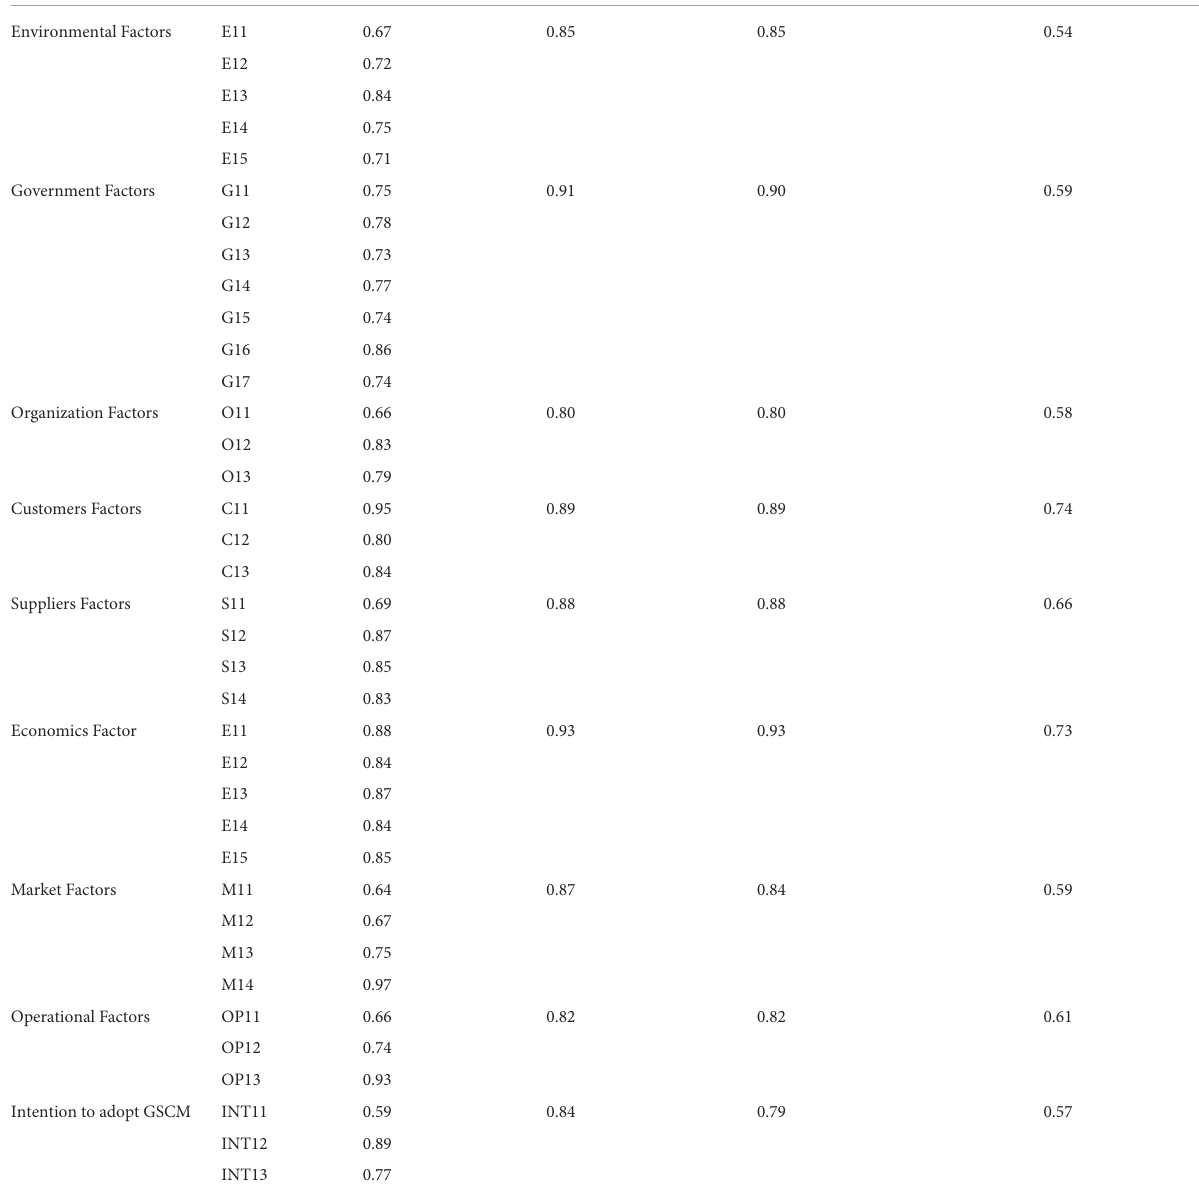
TABLE 6 Results of estimating the measurement model. Cronbach’ salpha Composite reliability Average variance extracted